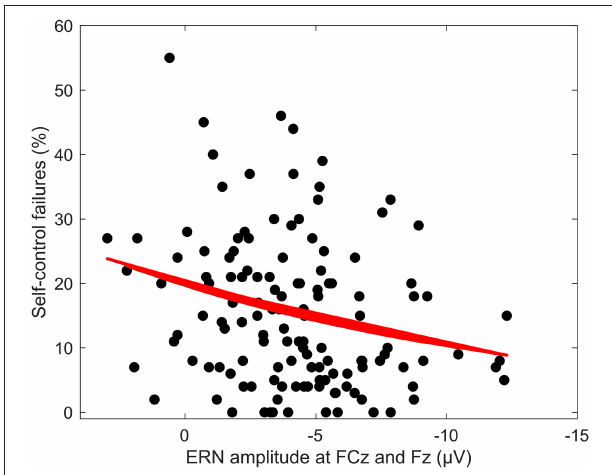
FIGURE 3 | Regression of ERN amplitude at FCz and Fz on SCF at 60 to 70ms. Regression of mean ERN amplitude at FCz and Fz between 60 and 70ms response-locked for incongruent error trials on amount of self-control failures per answered